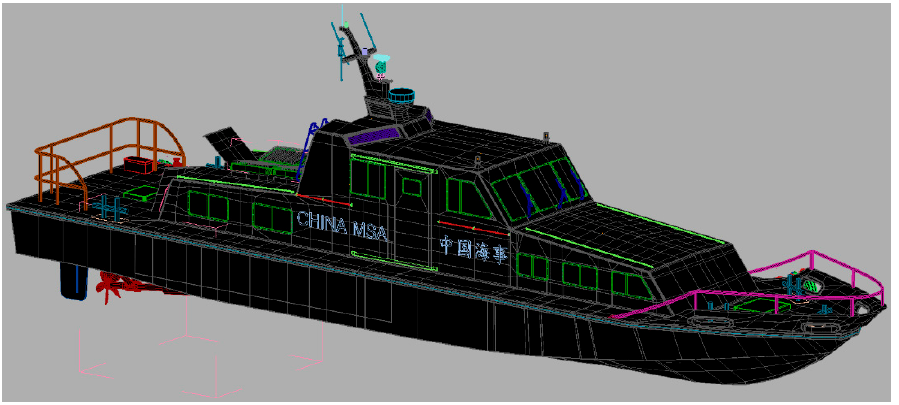
Figure 3. Overall structure of the patrol boat.